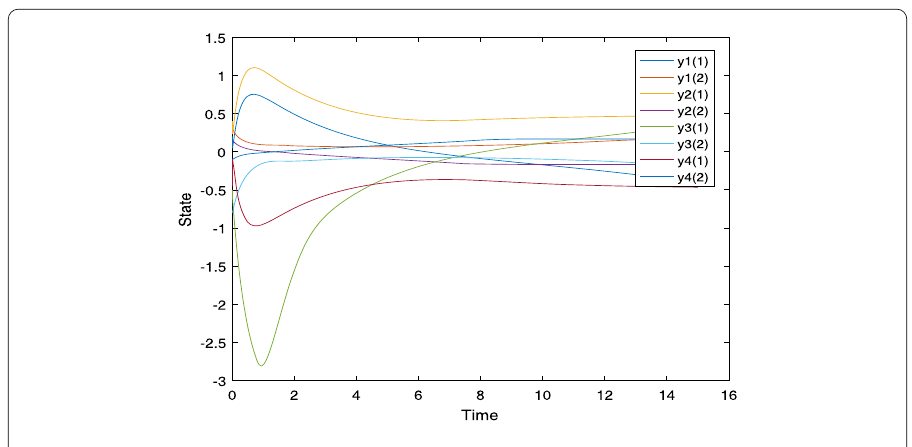
Figure 2 State trajectory of (4.2) without